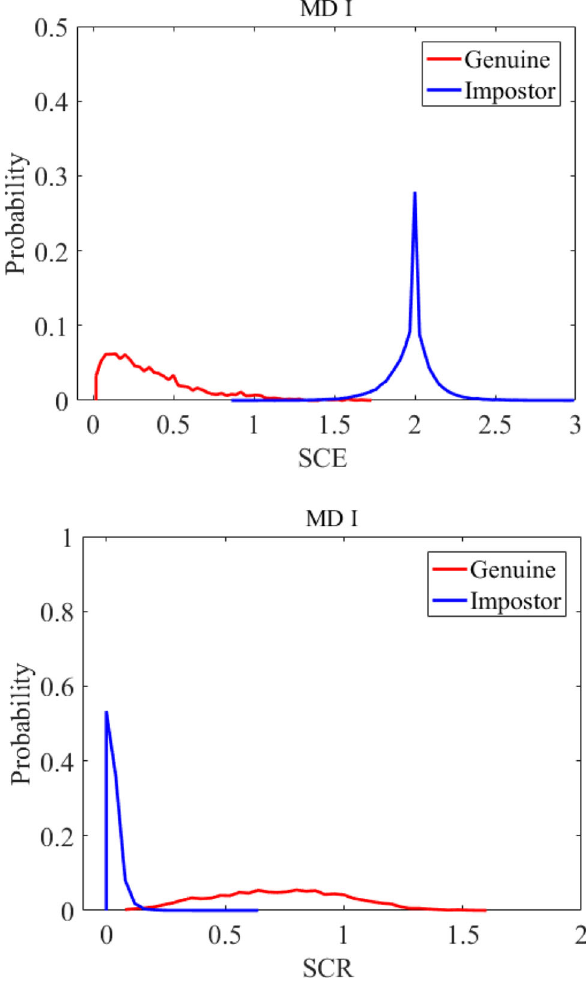
Fig. 9 Distributions of multimodal scores of SCE and SCR when using DCT features on MD